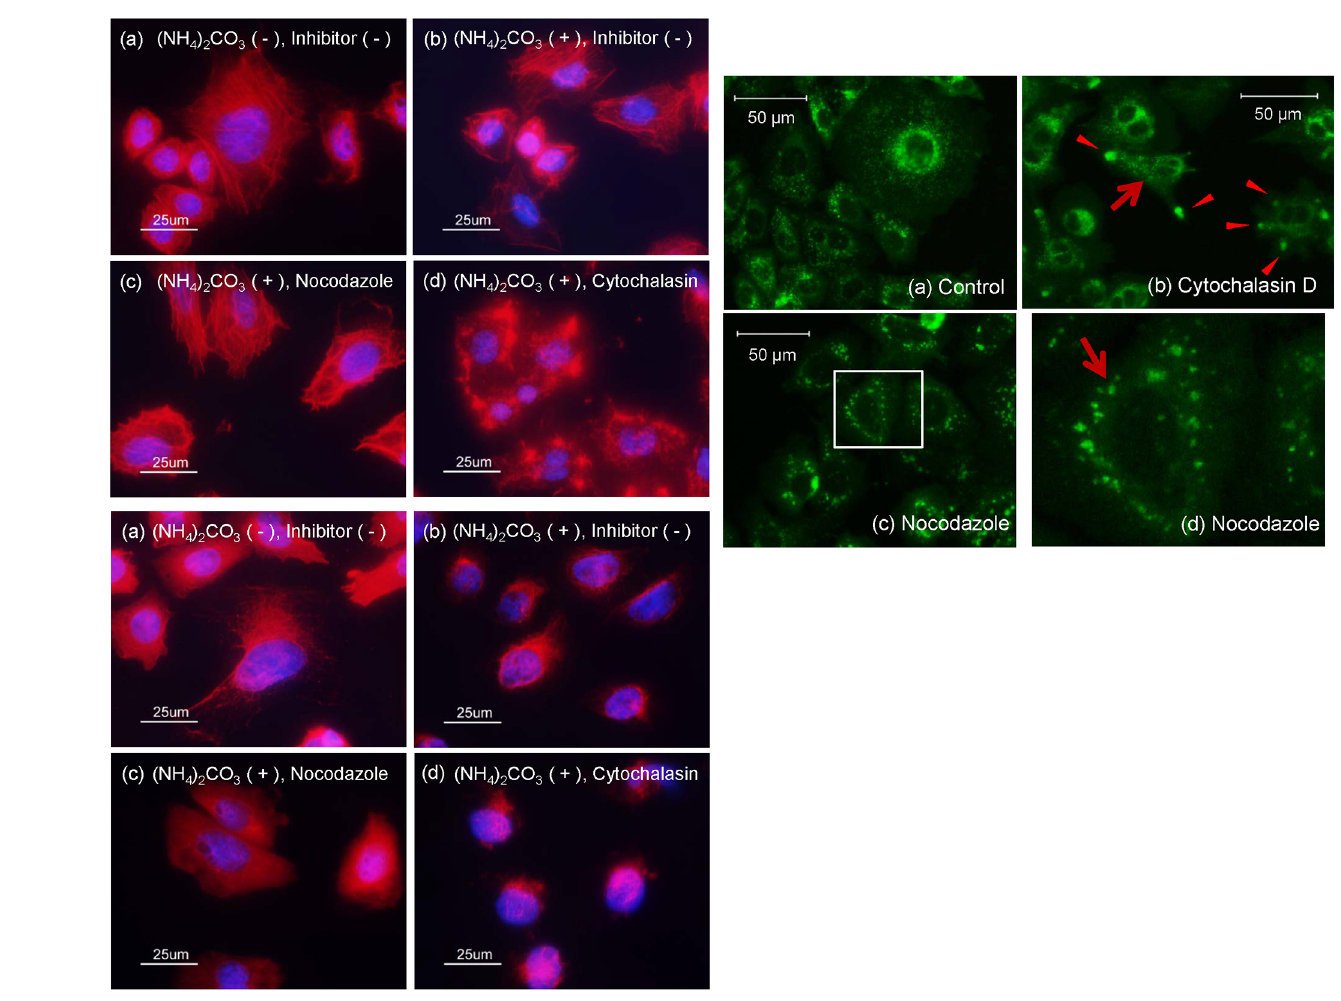
Fig 5. Effects of cytochalasin D and nocodazole on fluorescent autophagic puncta in GFP-MARCO-CHO cells. (A) Fluorescence staining of actin in GFP-MARCO-CHO cells. The cells were cultured for 15 hr in the absence (a) or presence of 4 mM (NH 4 ) 3 CO 3 (b-d), as follows: (b) without further stimulation; (c) with 1 μ M nocodazole; or (d) with 1 μ g/mL cytochalasin D. They were fixed with formalin solution and stained with rhodamine phalloidin and DAPI using standard immunofluorescence techniques. (B) Fluorescence staining of tubulin in GFP-MARCO-CHO cells. The cells were cultured and treated with chemicals as shown in Fig 5(A). They were fixed with formalin solution and treated with anti- α -tubulin followed by Alexa Fluor 1 594-conjugated secondary antibody and DAPI using standard immunofluorescence techniques. (C) The cells were cultured in the presence of 4 mM (NH 4 ) 3 CO 3 for 15 hr as follows; (a) without further stimulation, (b) with 1 μ g/mL cytochalasin D, or (c) with 1 μ M nocodazole. Fig 5C(d) provides a higher magnification image of the boxed area in (c). The arrows and arrowheads indicate autophagic puncta and interrupted macropinocytosis,